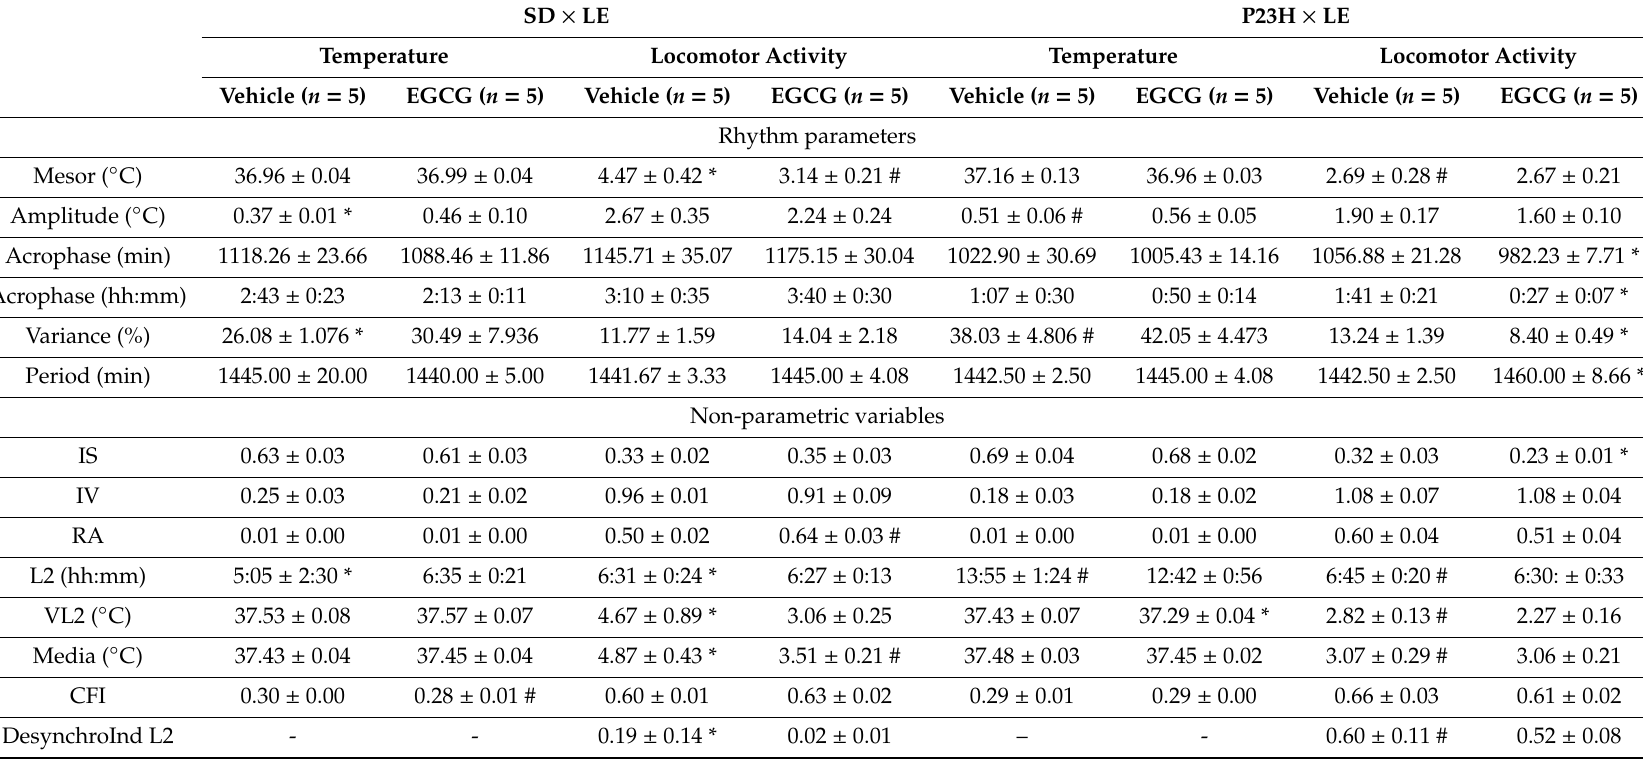
Table 1. Circadian